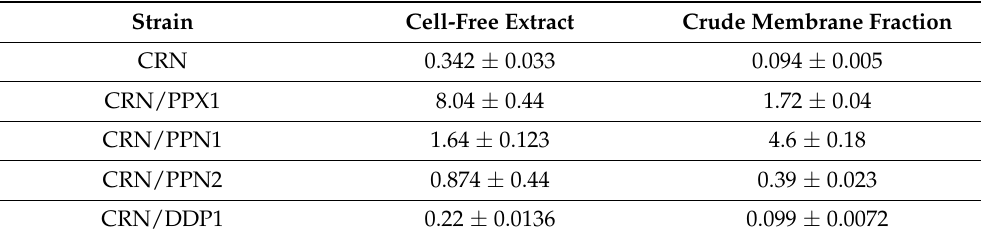
Table 1. Exopolyphosphatase activities (U/mg protein) in cell-free extracts and crude membrane fractions of S. cerevisiae CRN parent strain and strains overexpressing polyphosphatases. Strain Cell-Free Extract Crude Membrane Fraction CRN 0.342 ± 0.033